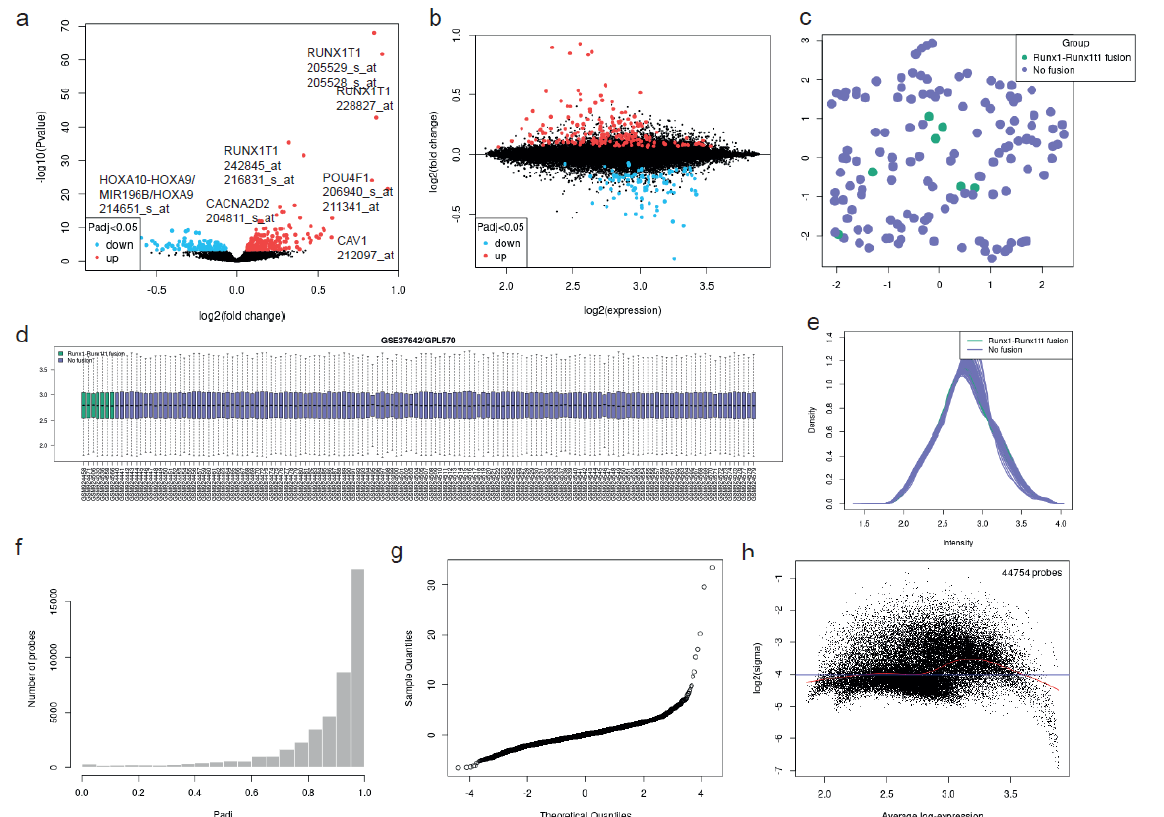
Figure 2. GSE37642 dataset analysis between RUNX1/RUNX1T1 fusion and RUNX1 AML patients. ( a ) The volcano plot depicts the statistical significance ( − log 10 p -value) against the magnitude of change (log 2 fold change) across the differentially expressed genes in adult RUNX1/RUNX1T1 AML patients. Highlighted genes are significantly deregulated (adj. p -value ≤ 0.05) (red = upregulated, blue = downregulated). ( b ) The mean difference (MD) plot displays the log 2 fold change versus the average log 2 expression of the differentially expressed genes in adult RUNX1/RUNX1T1 AML patients. ( c ) UMAP clustering shows that adult AML samples are related to each other irrespective of the RUNX1/RUNX1T1 fusion. ( d ) Distribution of the log transformed and normalized gene expression values and density curves ( e ) across all adult AML samples. The median-centered values indicate that the data are normalized and cross-comparable. ( f ) The histogram depicts the distribution of the p -values. ( g ) Moderated t-statistic quantile-quantile (q-q) plot. ( h ) Mean-variance trend plot, in which each dot represents a gene, and it shows the mean–variance relationship of the genes in the dataset. The blue line is constant variance approximation.